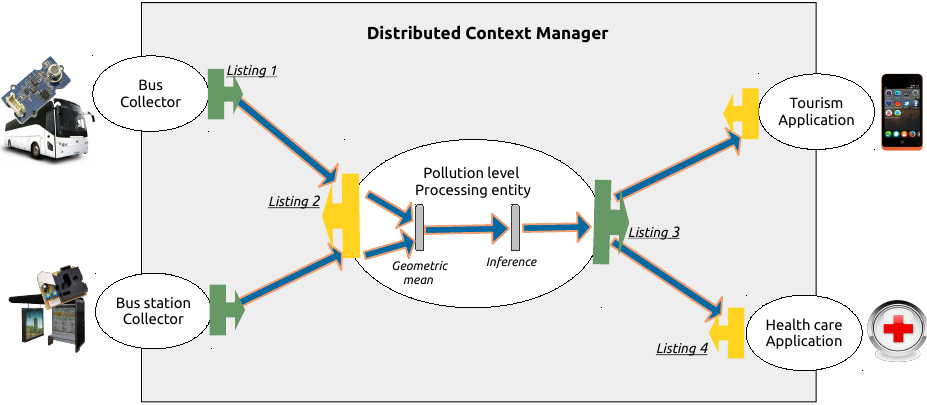
Figure 8. The routing filters used in the scenario to provide the pollution level of a